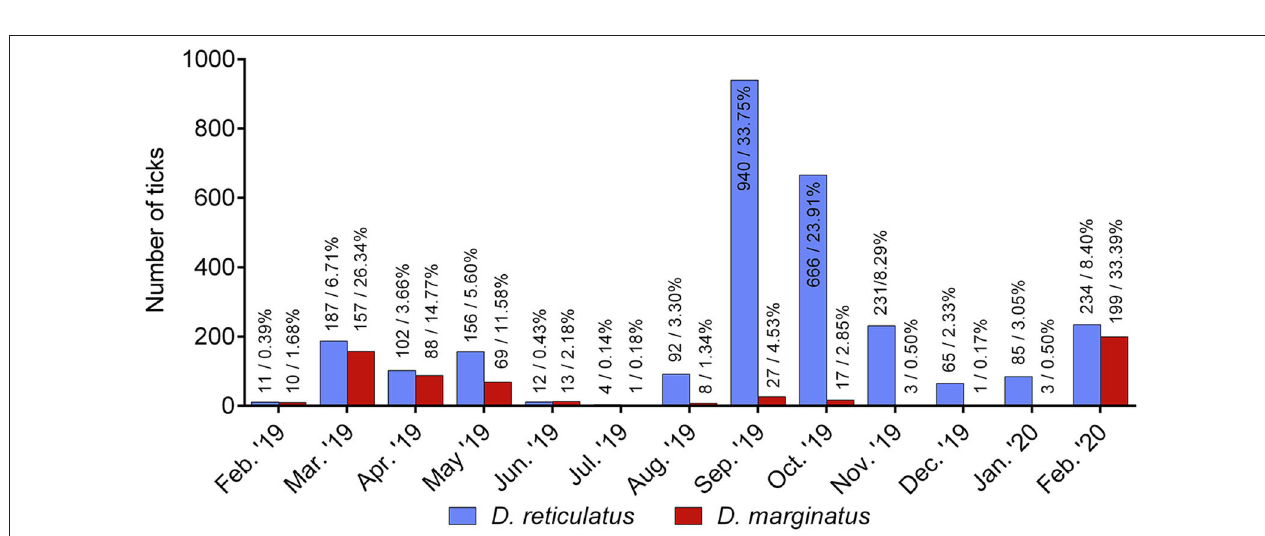
FIGURE 3 | Dermacentor reticulatus ( N = 2,785) and Dermacentor marginatus ( N = 596) specimens by month of collection, sent in by German citizens from February 2019 to February 2020.